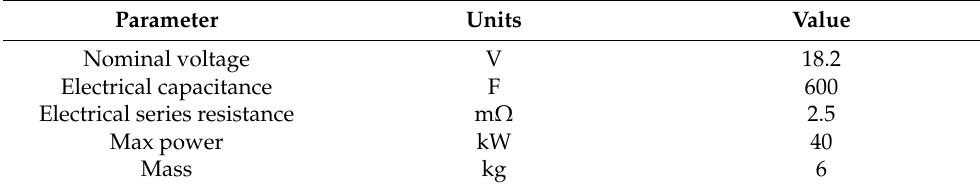
Figure 4. Characteristic curves of ultra-capacitors ( a ) Charging characteristic curves ( b ) Discharging characteristic curves. Table 2. Main specifications of the ultra-capacitors.